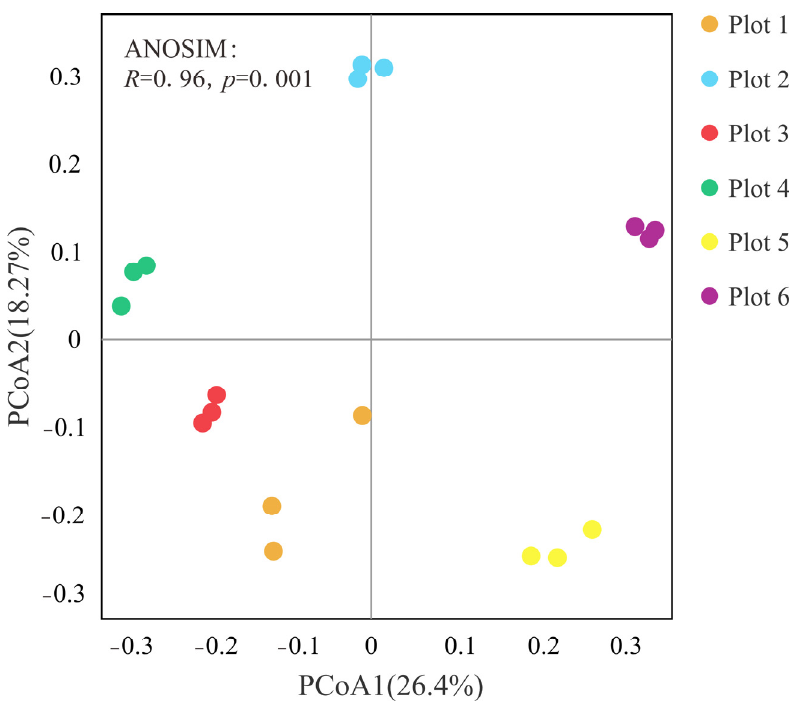
Figure 2. Principal component analysis (PCoA) of bacterial community structure. The α -diversity indices of soil bacteria in different plots were calculated and statisti- cally analyzed (Table 3). It was found that the Chao1 and ACE indices of soil bacteria in Plot 4 and the Shannon and Simpson indices in Plots 5 and 6 were significantly higher than those in Plot 2 ( p < 0.05). None of the four indices showed an increasing pattern with the increase in reclamation years. Table 3. Soil bacterial α -diversity indices in different plots. Sample